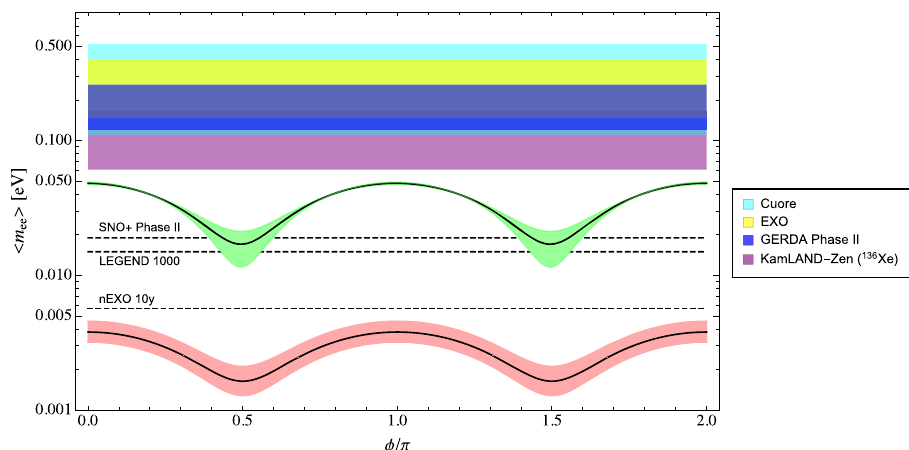
Fig. 2 Effective 0 ν 2 β Majorana mass parameter versus the Majorana phase. The pink (light green) band represents the prediction for the 3 σ C.L. region allowed by current oscillation experiments for normal (inverted) mass